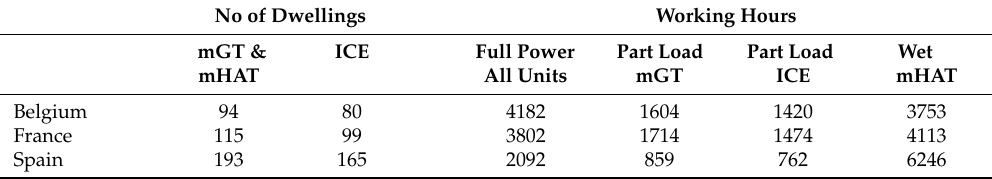
Table 4. Results of the sizing methodology: grouping of dwellings per country and working